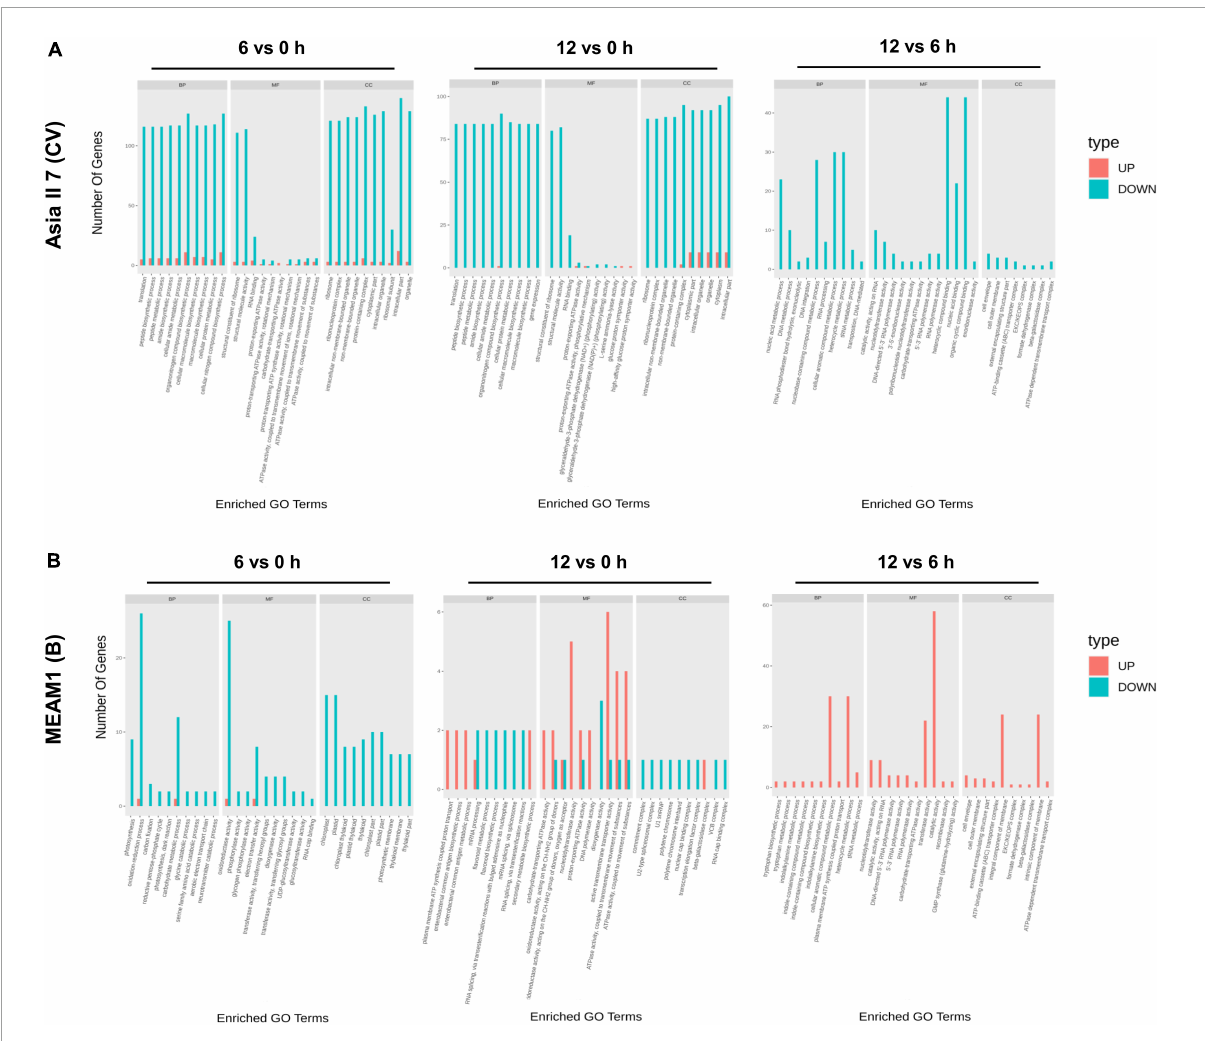
FIGURE5 Gene ontology (GO) analysis represents the number of upregulated and downregulated genes enriched in different pathways among subgroups of (A) Asia II 7 and (B) MEAM1 whiteflies at 0, 6, and 12 h of CLCuMuV infection. The significance level based on the p -value is expressed by red (high) to yellow (low)